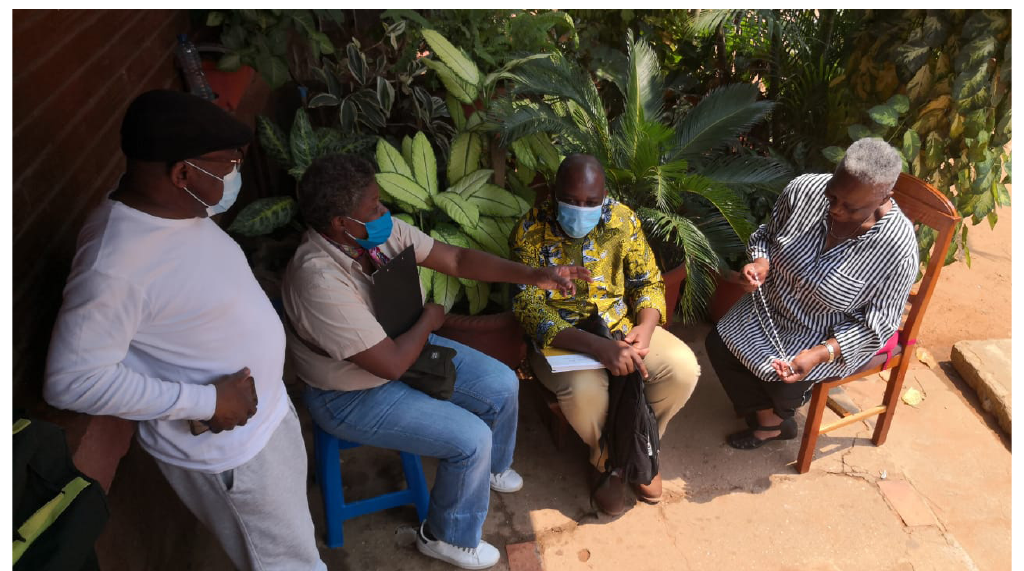
Figure 12. Population survey of CTT block, Luanda. Source: Courtesy of Filomena Espírito